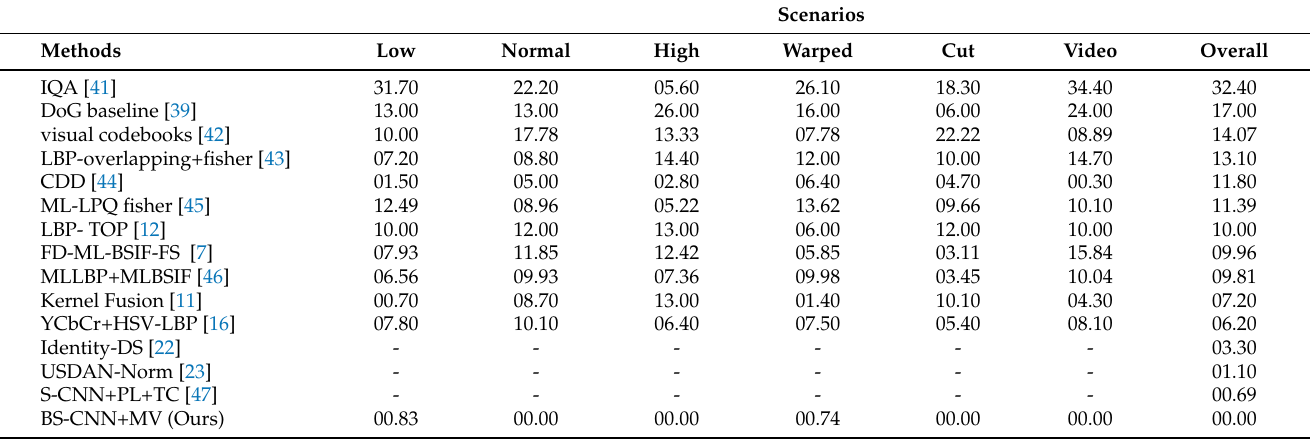
Table 2. Comparison EER (in %) between the proposed approach and the state-of-the-art methods on different scenarios on CASIA